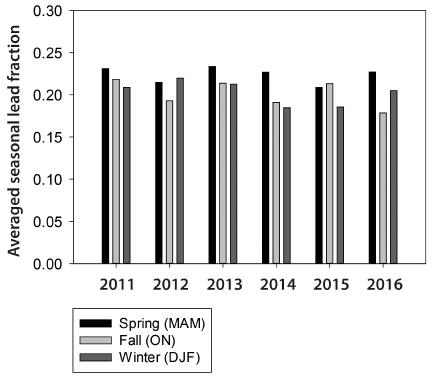
Figure 8. Averaged seasonal lead fraction in spring (MAM), fall (ON), and winter (DJF) between 2011 and 2016. The lead frac- tion from June to September was not available because leads were hard to distinguish from melt ponds using CryoSat-2 in the summer